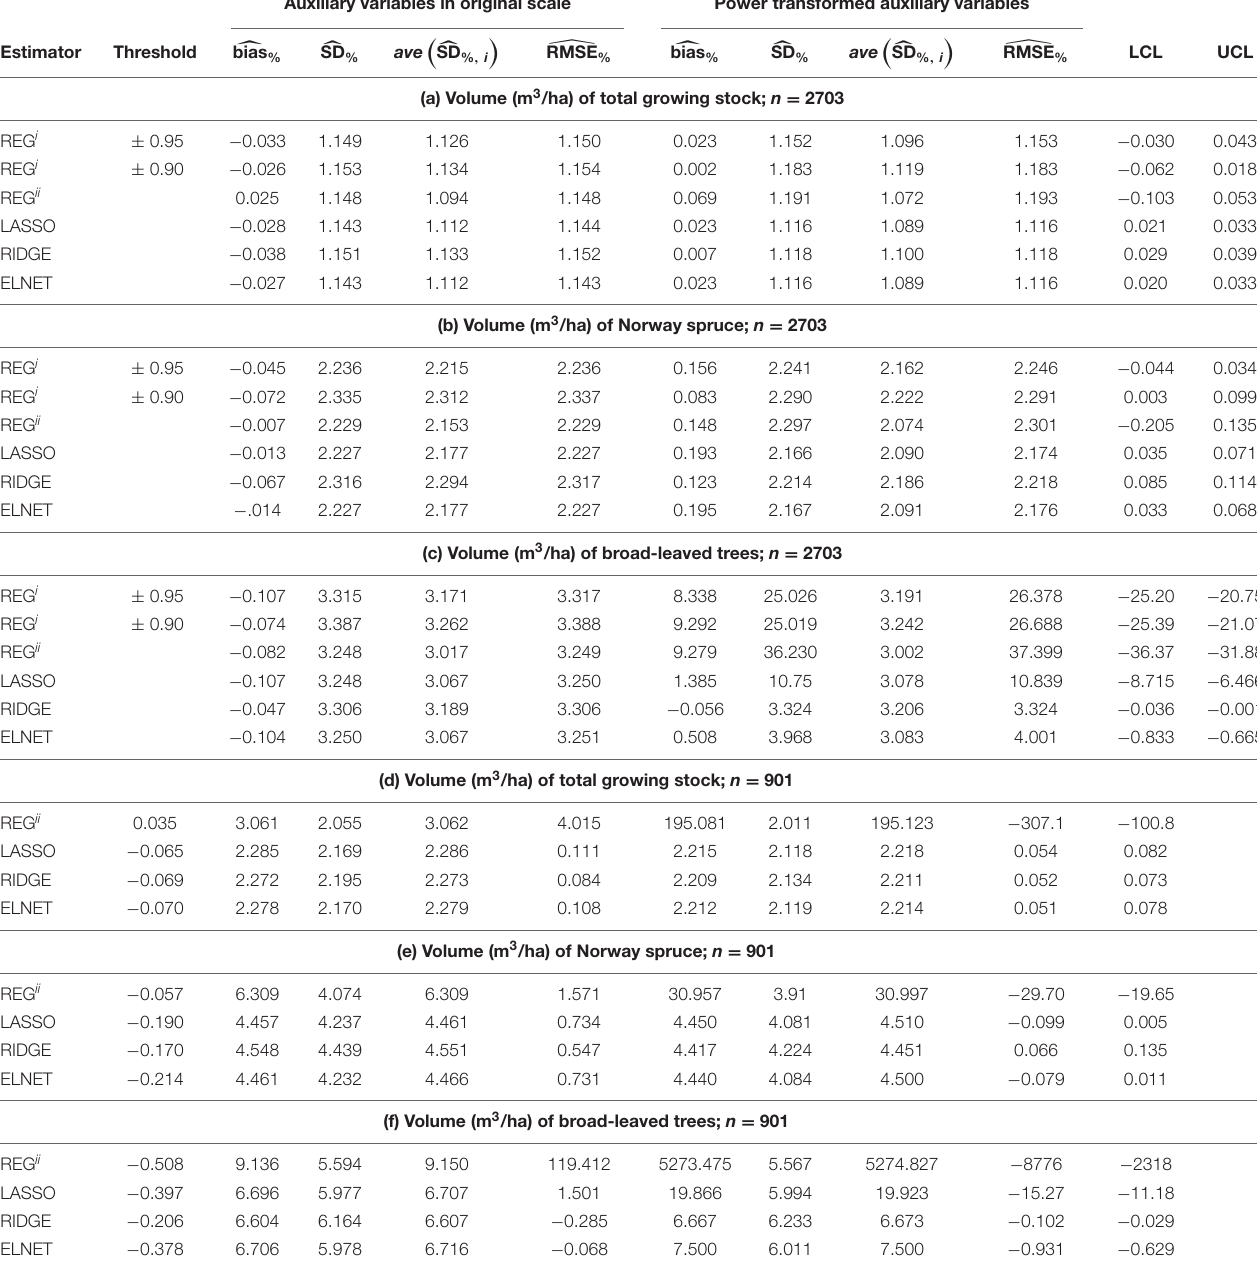
TABLE 6 | Monte Carlo results for REG i , REG ii , LASSO, RIDGE, and ELNET, when based on all auxiliary variables. Auxiliary variables in original scale Power transformed auxiliary